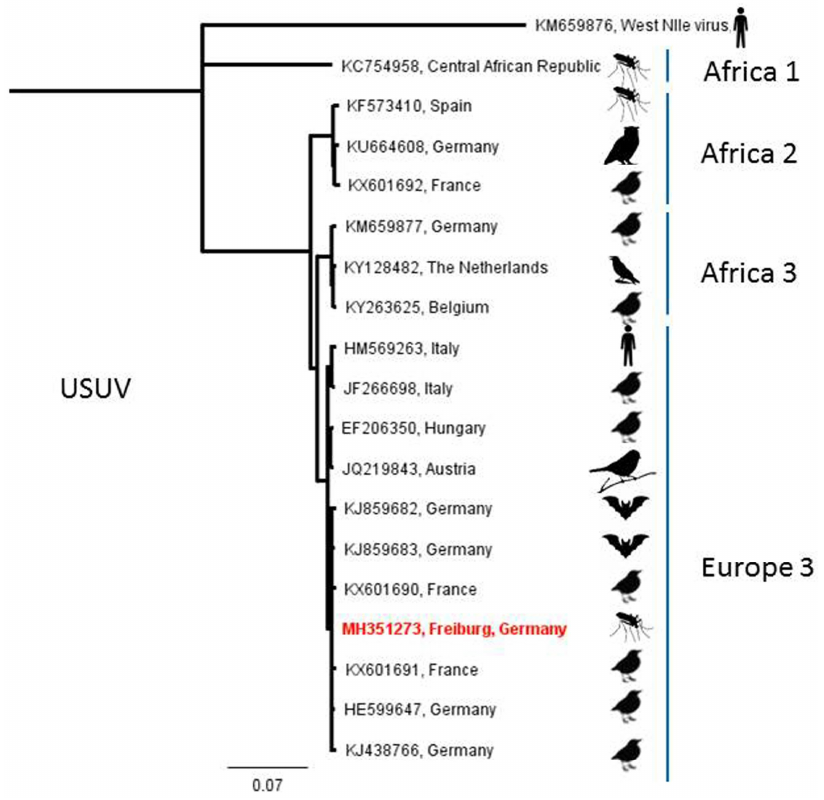
Figure 3. Phylogenetic tree of USUV sequences based on 975 nucleotides of the envelope protein. Red text marks sample of this study.